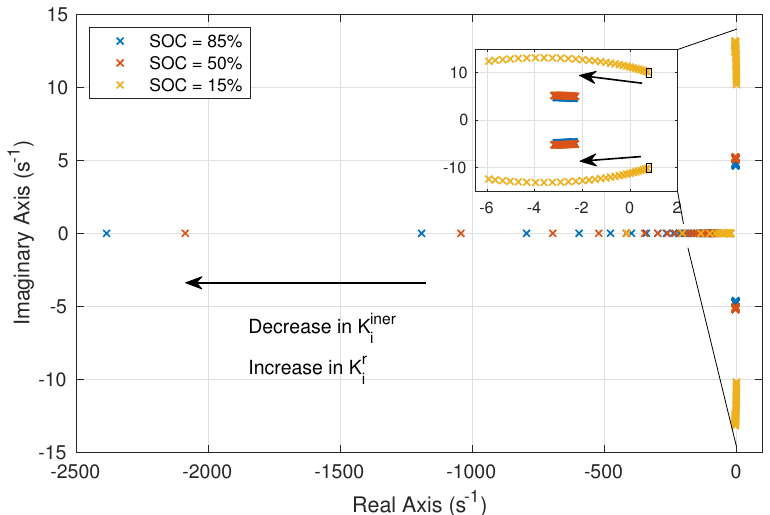
Figure 7. Eigenvalues trajectories of the third-order small-signal model of the proposed control system with increase in K r and decrease in K iner . i i